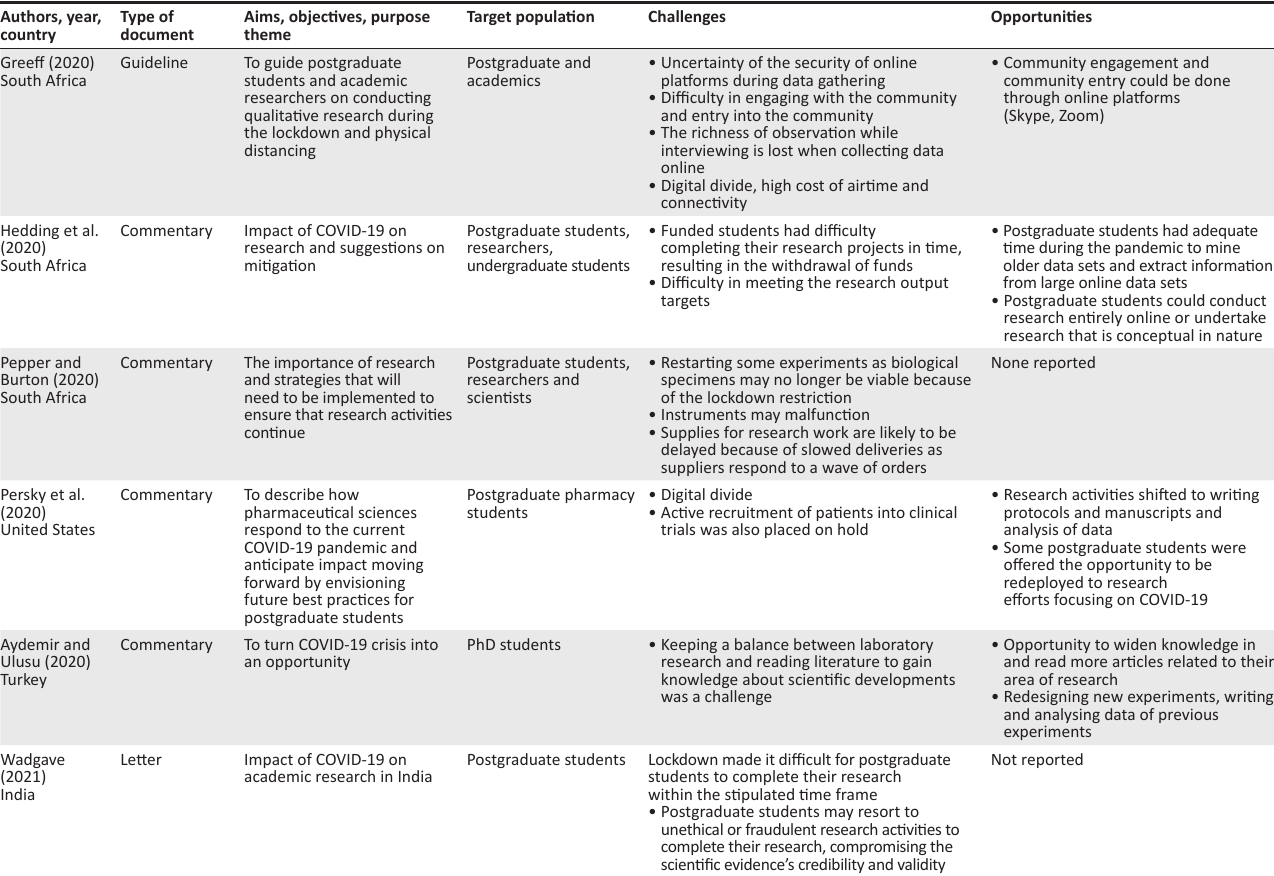
TABLE 3: Summary of guidelines, commentaries and letters included in the scoping review. Authors, year,